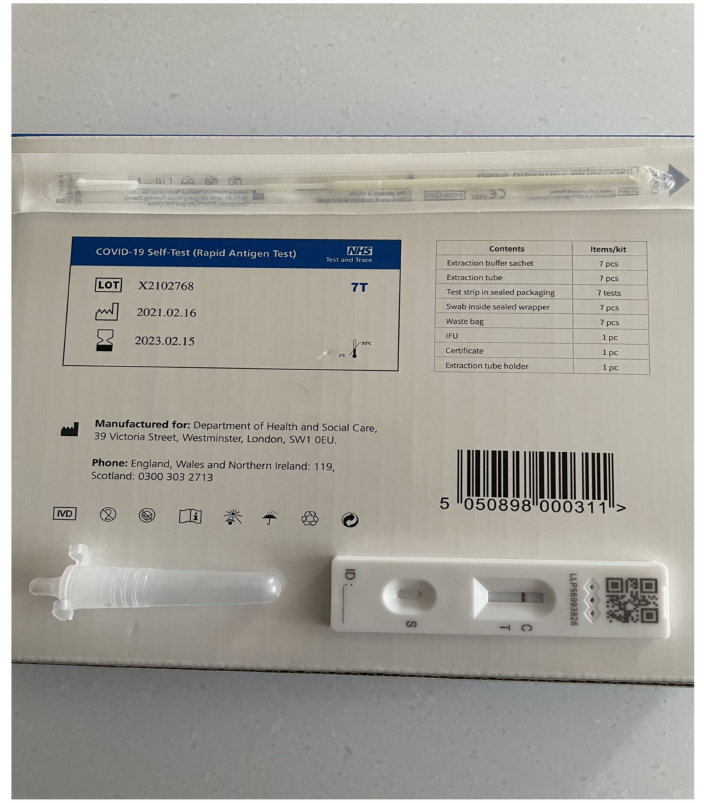
Figure 1. A SARS-CoV-2 antigen home testing